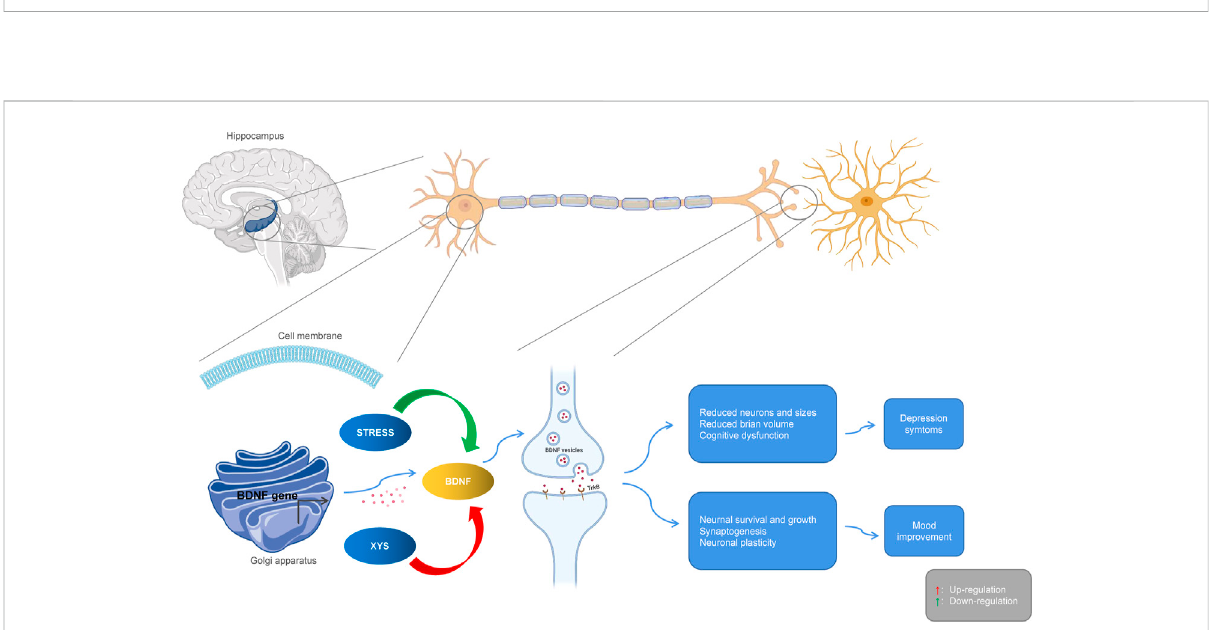
FIGURE 4 Interactions between Xiaoyaosan, depression and BDNF. Stress downregulates BDNF, leading to atrophy and loss of hippocampal neurons, producing depressive symptoms. Xiaoyaosan up-regulates BDNF, promotes neuron survival and synaptogenesis, and improves depressive mood. Red arrows indicate upregulation. Green arrows indicate